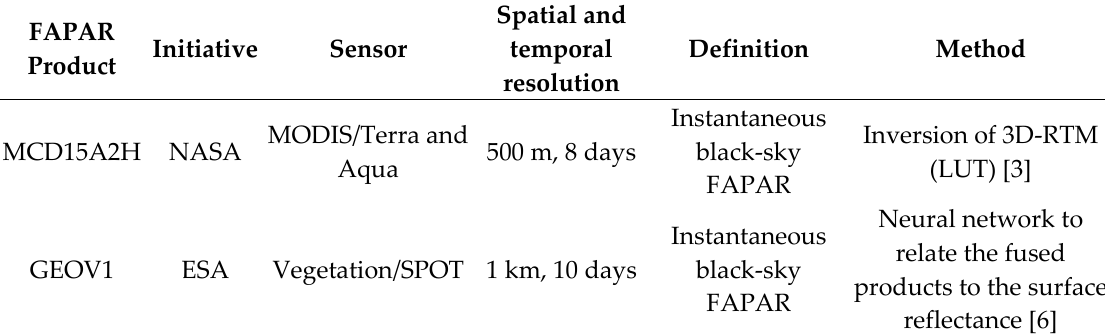
Table 1. The main characteristics of the MODIS and GEOV1 FAPAR products, including definition, retrieval method, and